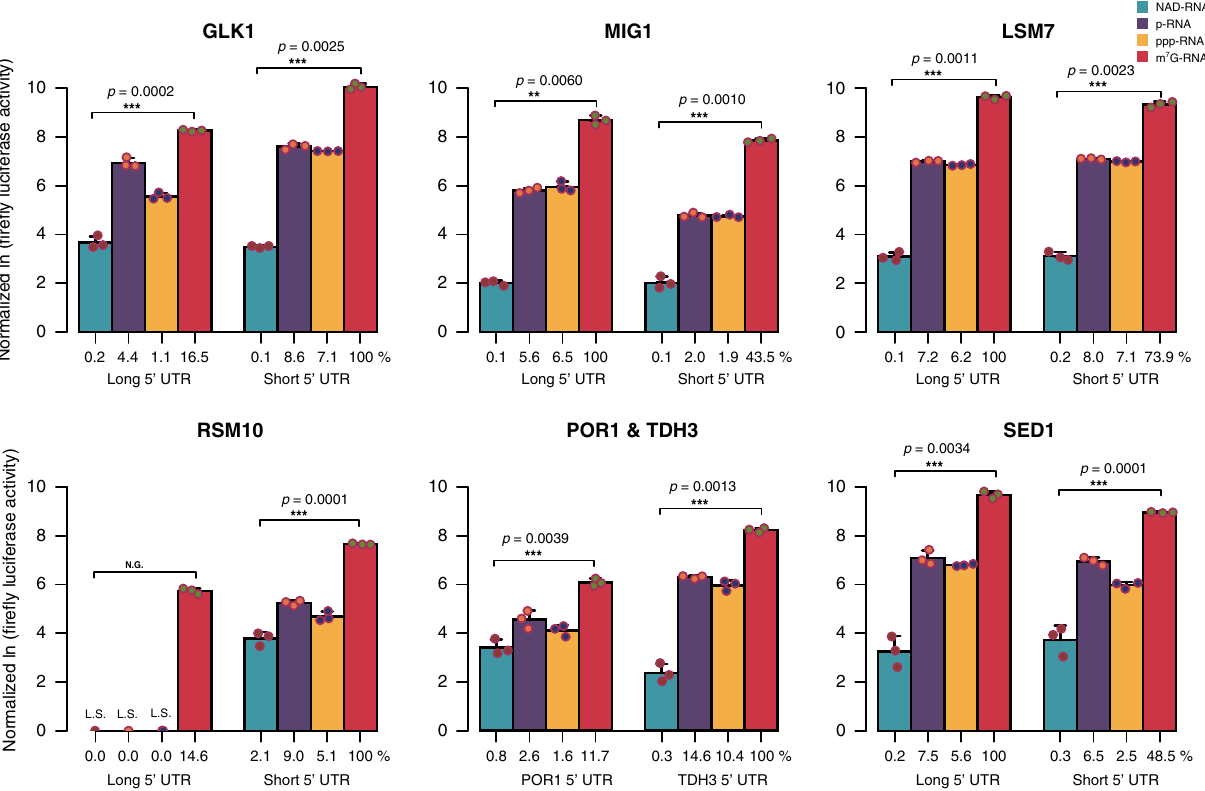
Fig. 10 In vitro translation of NAD-RNA with shifted TLs. In vitro translation of NAD- RNA, p-RNA, ppp-RNA, and m 7 G-RNA with short or long TL sequences. Probed mRNAs, bearing a 5 ′ -NAD-, 5 ′ -p-, or 5 ′ -ppp-terminus, contain the alternative TL sequences identi fi ed in NAD captureSeq, followed by 22 nt of the CDS of the corresponding gene, followed by the fi re fl y luciferase CDS (1653 nt) and a poly(A) 30 tail. Reference m 7 G-capped mRNA contains Renilla luciferase CDS (936 nt) and a poly(A) 30 tail. Fire fl y luciferase activity was normalized to Renilla luciferase activity, then normalized to the C t -value of the full-length mRNA determined by qRT-PCR. NAD-capped mRNAs, p-mRNAs, and ppp-mRNAs contain the same sequence as the corresponding m 7 G- capped RNAs. Logarithmic representation of normalized luciferase activity. Blue, NAD-RNA; purple, p-RNA; orange, ppp-RNA; red, m 7 G-RNA. The percent values below the bars indicate relative luciferase activity normalized to the m 7 G-capped mRNA of that species with the higher luciferase expression. L.S. denotes that the luciferase signal was not signi fi cantly above the background. Error bars represent mean + SD. Three independent experiments were performed, n = 3. p -values are denoted by asterisks: * p < 0.05; ** p < 0.01; *** p < 0.005 (Student ’ s t -test, NAD-RNA vs. m 7 G-RNA, one sided). Source data are provided as a Source Data fi